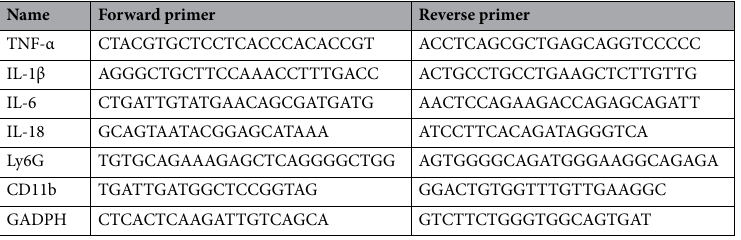
Table 2. Primer sequences used for PCR analyses.